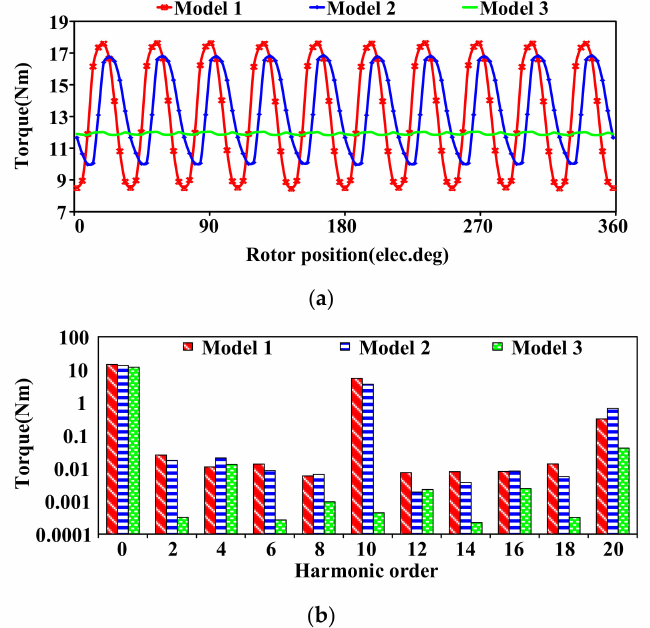
Figure 12. Torque of the three models. ( a ) Waveforms. ( b ) Harmonics on the